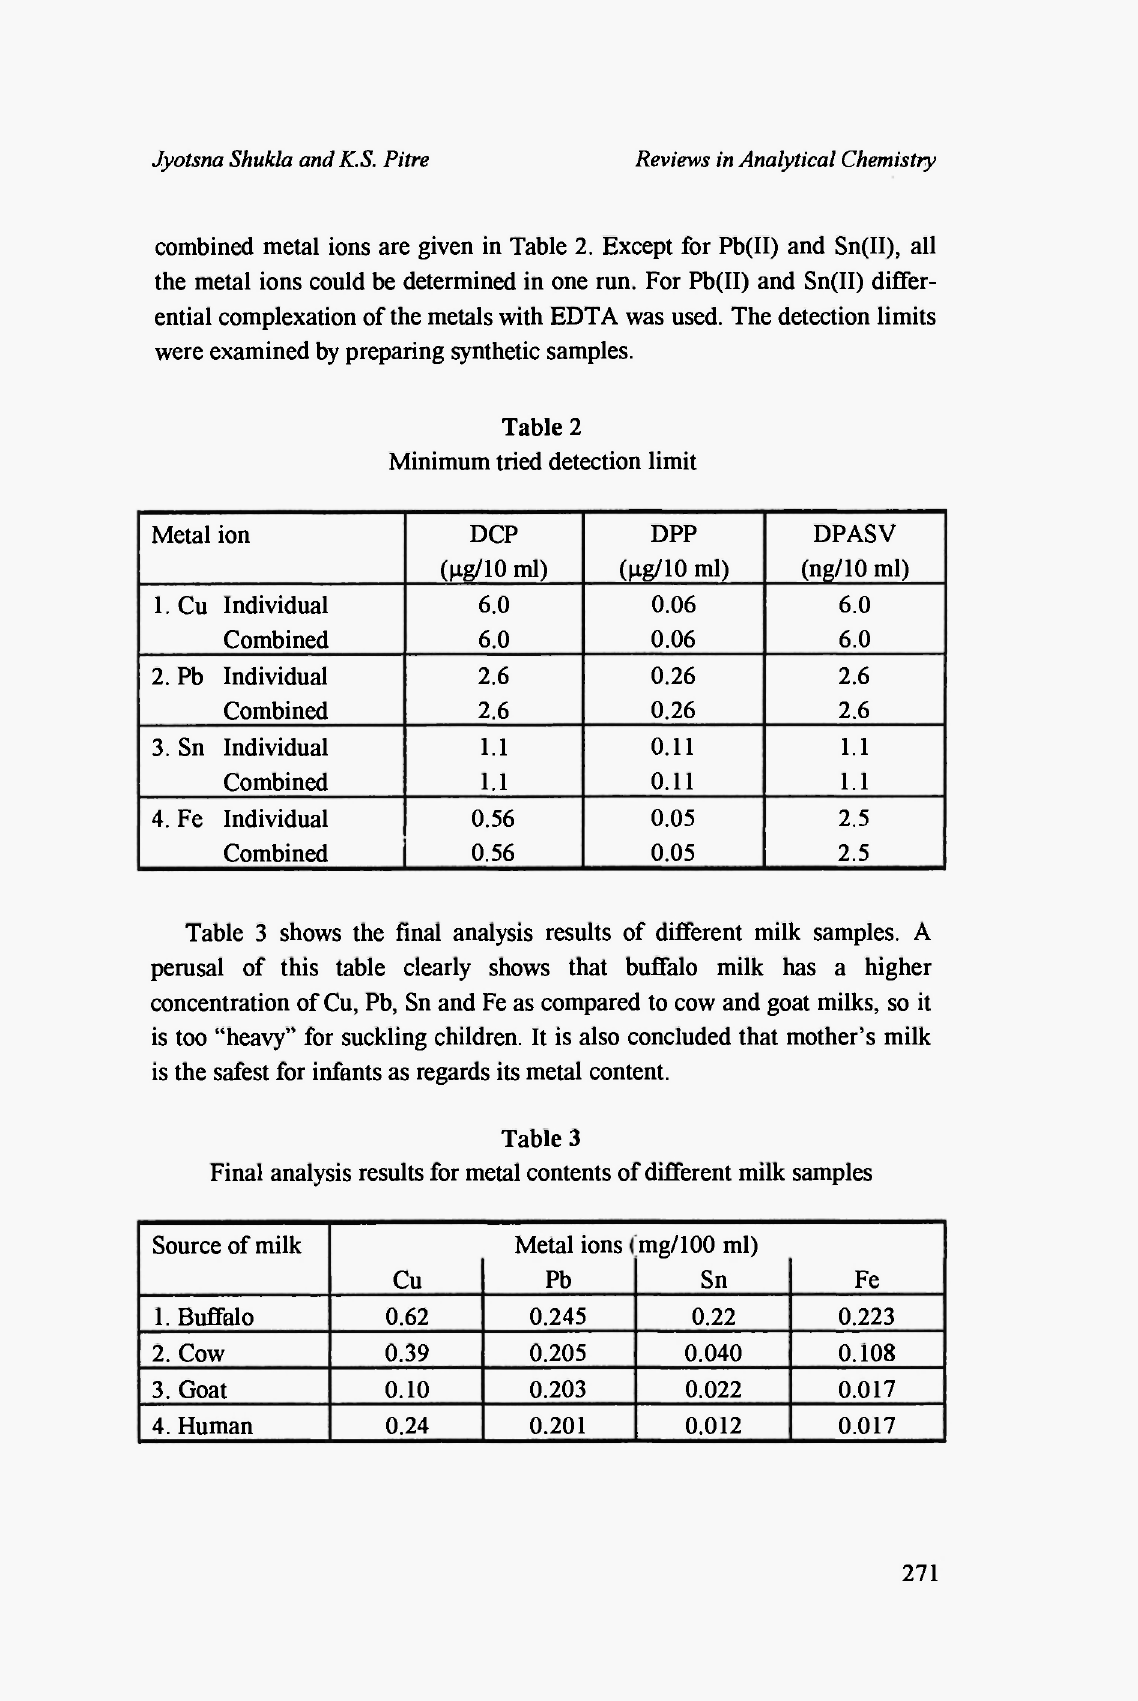
Minimum tried detection limit